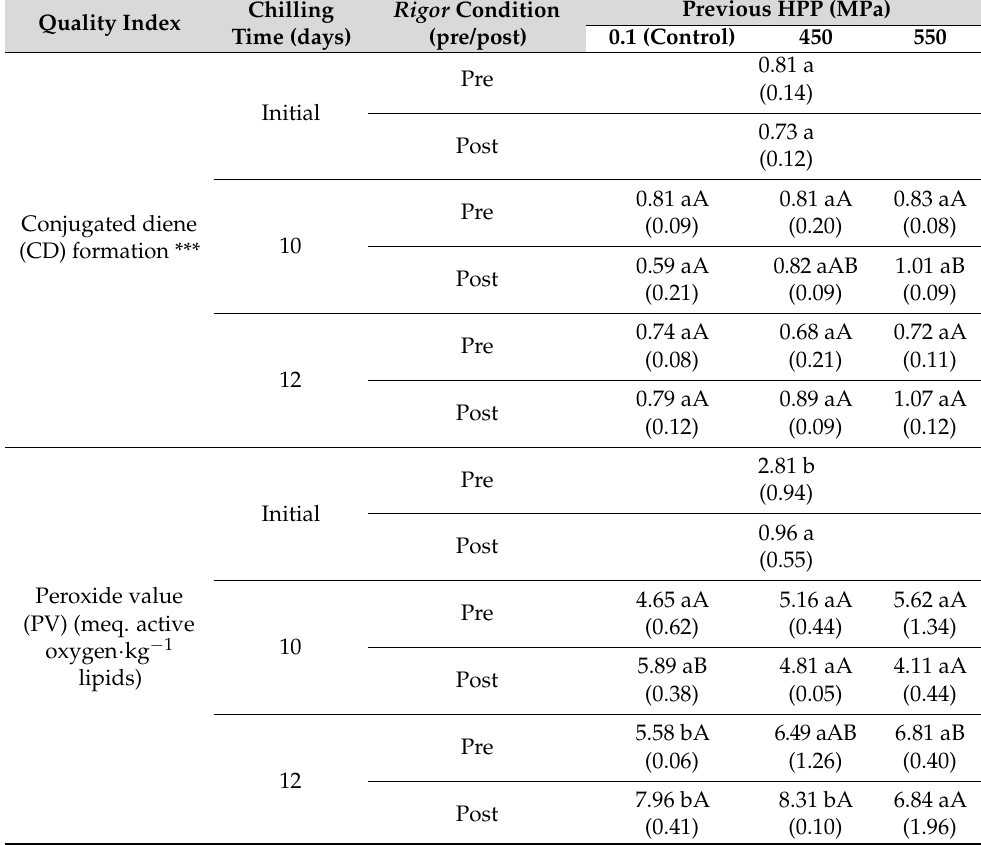
Table 2. Lipid oxidation determination * in chilled palm ruff corresponding to different initial rigor conditions and previous high-pressure processing (HPP)